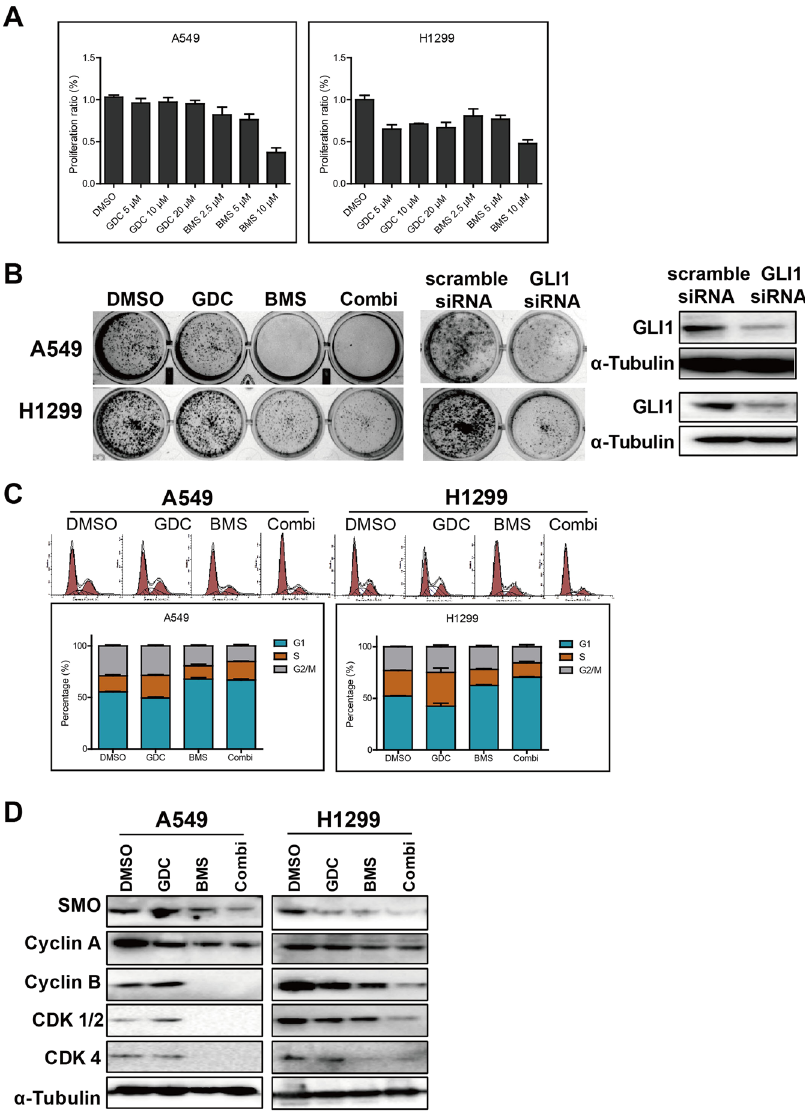
Figure 2. Targeting SHH signaling reduces cell proliferation and clonogenicity of NSCLC via arresting cell cycle. ( A ) CCK-8 assay showing that SMO inhibitors BMS (BMS-833923) inhibited cell proliferation of both A549 and H1299 at the 2.5 µ M concentration or higher. SMO inhibitors GDC (GDC-0449) significantly arrested H1299 not A549 cell growth at 5 µ M concentration or above. ( B ) The representative images of colony formation of A549 and H1299 cells treated with GDC (10 µ Μ ), and/or BMS (5 µ M), or siRNA-GLI1 from clonogenicity assay. ( C ) Flowcytometry analysis demonstrating that GDC and/or BMS significantly induced G1/S phase arrest in A549 and H1299 cells, in which additive G1/S arrest was induced with co-treatment of GDC and BMS. Data were analyzed by ModFit software and presented as mean ± SD. ( D ) Immunoblotting analysis demonstrating that GDC and/or BMS significantly reduced protein level of SMO and cell cycle regulators (Cyclin A, Cyclin B, CDK1 and CDK4) in A549 and H1299 cells, in which additive repression of SMO and those cell cycle regulators G1/S arrest was detected with co-treatment of GDC and BMS. α -Tubulin was loaded as inner control. All the co-treatments of GDC and BMS were labeled as “Combi” in this